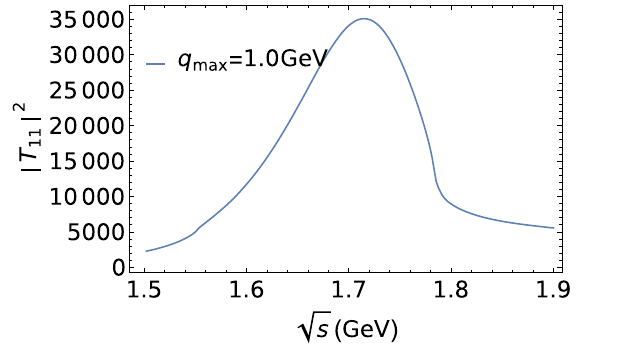
Fig. 3 | T 11 | 2 for (cid:7) = 1 . 0 GeV and q max = 1 . 0 GeV in 2-dim and 3-dim